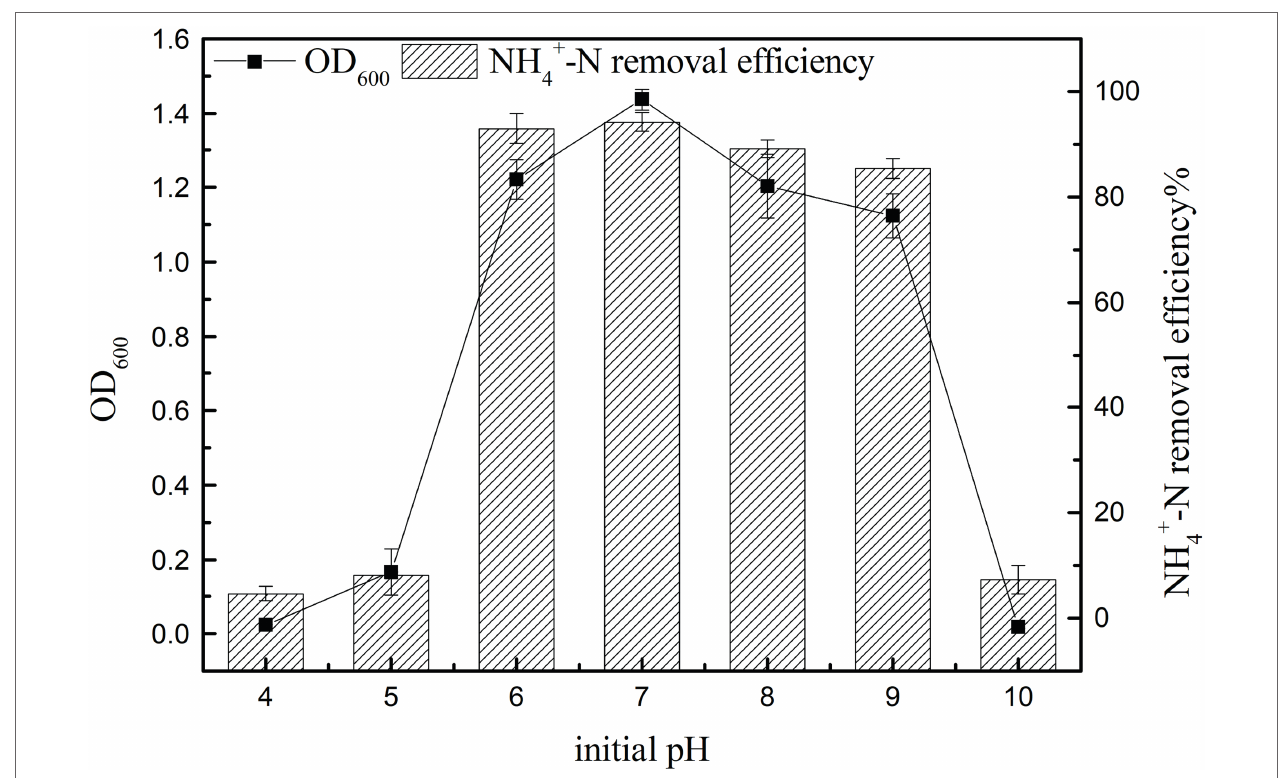
FIGURE 7 | Effect of initial pH on the growth and ammonia nitrogen removal efficiency of strain K17. The initial ammonia nitrogen concentration was 100 mg/l, and the mixture was cultured at 165 rpm and 30 ° C for 12 h.